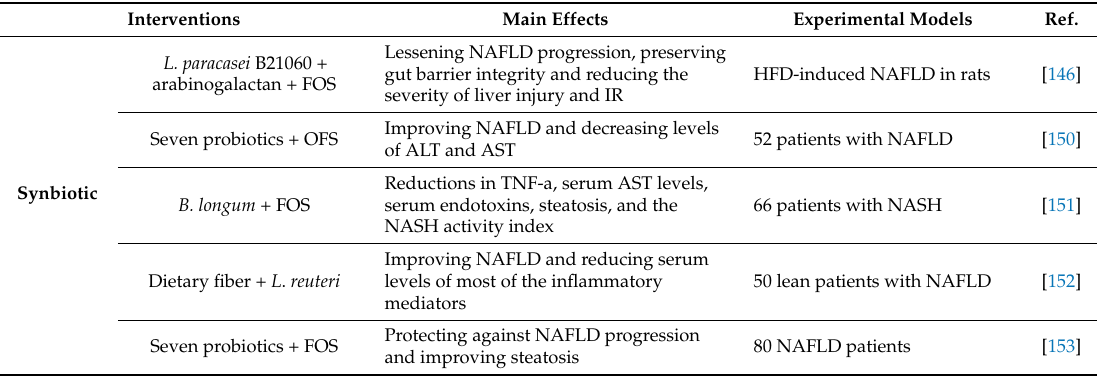
Table 3. Gut microbiota-targeted therapies of NAFLD with synbiotics. Interventions Main Effects Experimental Models